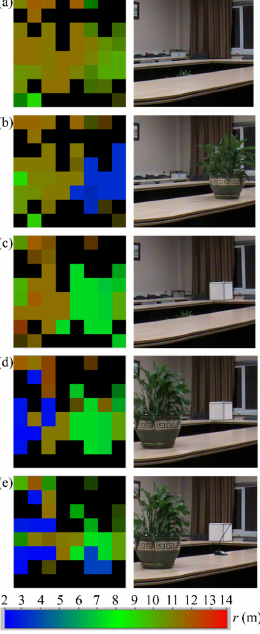
Figure 13. MMW images ( left ) and the related photographs ( right ) of a room region. The range to an object is indicated by color in accordance with a scale shown at the bottom of the figure. ( a ) An initial arrangement of the room. ( b ) A flowerpot is placed on the table. ( c ) The flowerpot is removed; a box is placed on the table. ( d ) The flowerpot is added toward the left. ( e ) A microphone is added.